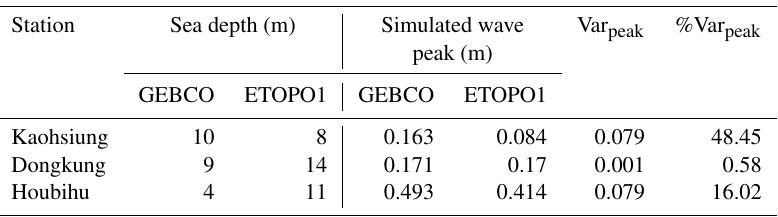
Figure 18. Comparison of simulated tsunami waveforms at the Dongkung and Houbihu stations using nine cases of multiple fault models (solid blue lines) and a single fault model of S7 (solid red lines). The simulated tsunami waveforms using the multiple fault model (LS2) are shown as dashed blue lines. The white circles represent the observational data. Table 8. Details of the locations of the simulated tsunami waveforms and misfit of model results using different open-source bathymetry data at three tide gauge